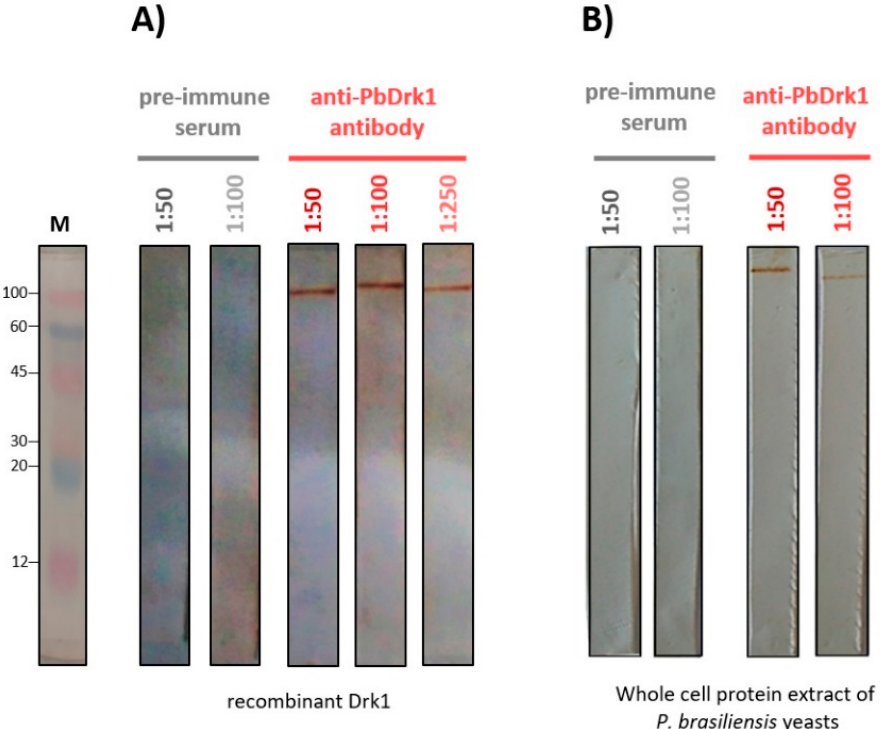
Figure 2. Western blotting of recombinant Drk1 and P. brasiliensis proteins recognized by anti-Drk1 antibody. Western blotting of ( A ) recombinant and ( B ) native Drk1 of P. brasiliensis . The non-specific reaction was evaluated using a pre-immune serum. M: standard protein marker (ColorBurst TM Sigma-Aldrich, Saint Louis, MO, USA; 8–220 kDa). The molecular mass is indicated on the left in kilodaltons (kDa).